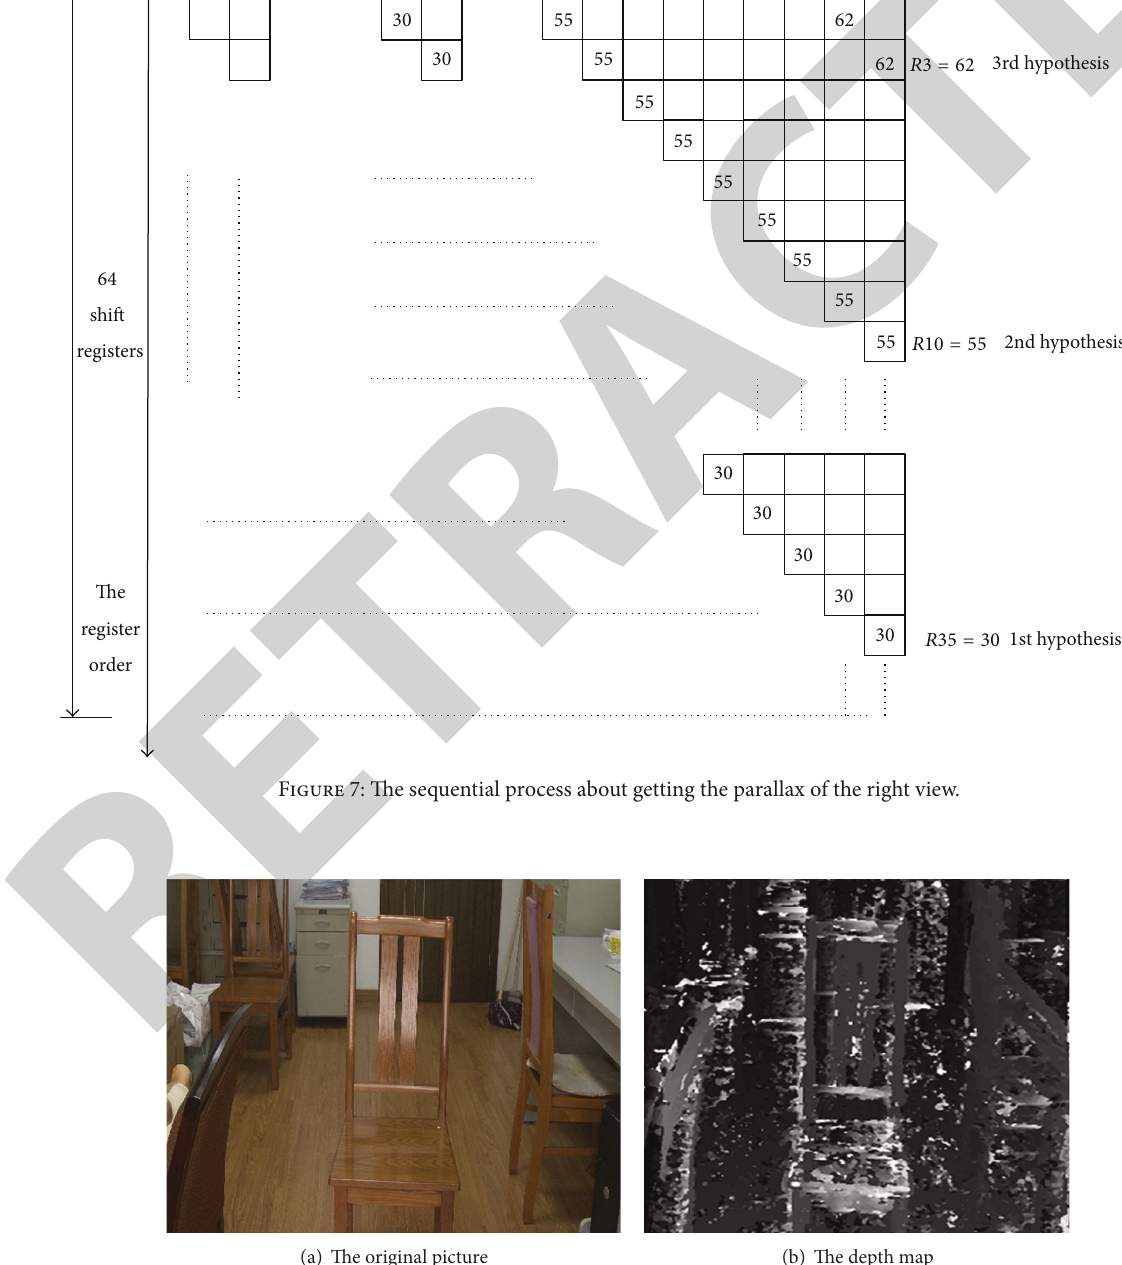
Figure 8: The extraction of the depth